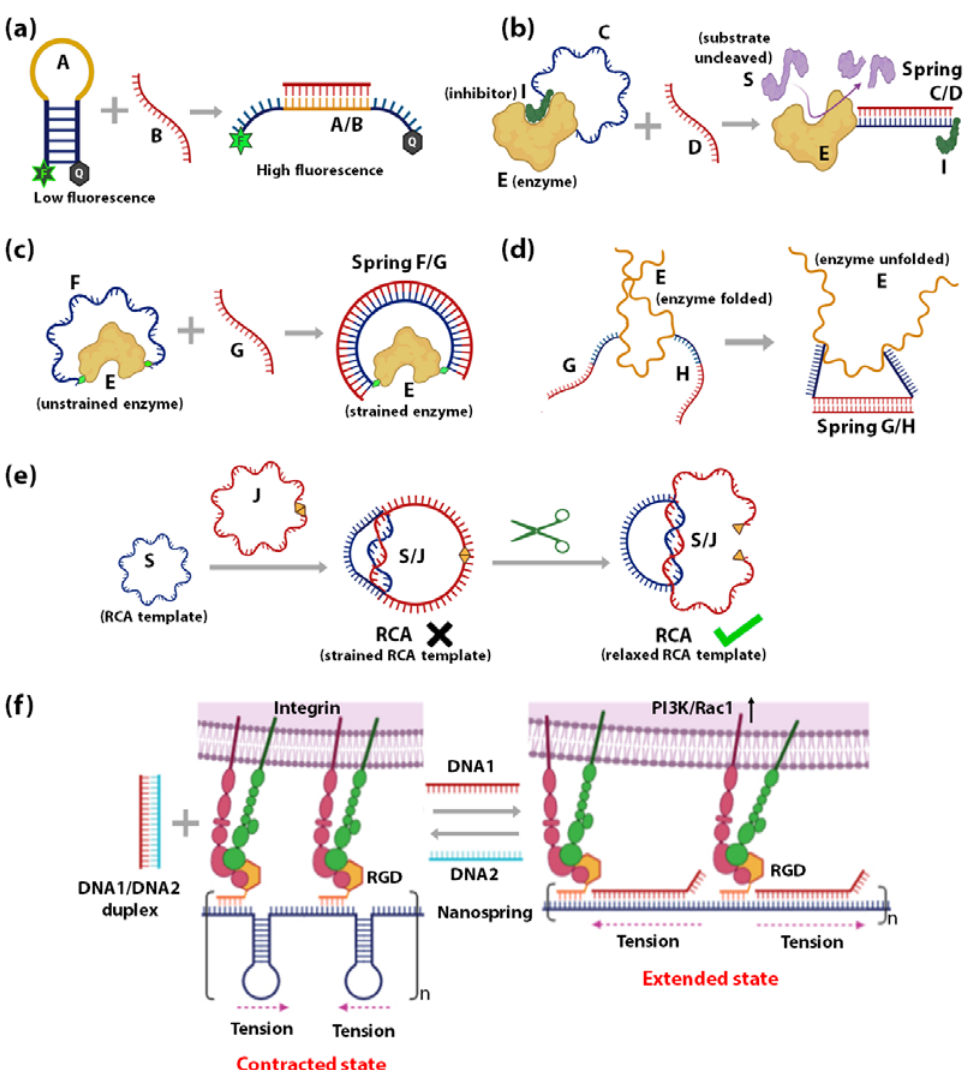
Figure 2. ( a ) Schematic representation of a DNA spring where the increased stiffness of A/B duplex does not allow the two ends of strand A to self-hybridize [116]. Schematic representation of a DNA spring regulating the catalytic activity of enzyme E ( b ) by altering the spatial proximity of the enzyme-inhibitor I with the help of the stiffness of C/D duplex [117] ( c ) by exerting mechanical force (generated due to the stiffness of F/G duplex) on the enzyme itself [115] ( d ) by pulling apart the ribozyme E tertiary structure causing it to misfold by the formation of G/H duplex [118]. ( e ) Schematic representation of a topological constraint J regulating the activity of an RCA DNA polymerase by exerting strain on the RCA template S by S/J duplex formation [119]. ( f ) Schematic representation of a DNA nanospring regulating mechanical tension by contracting membrane-bound integrins [120] . (i) Influencing the accessibility of regulatory molecules: The first strategy using DNA springs to regulate enzymes is by controlling the accessibility of enzyme regulatory factors, e.g., inhibitors. Ghadiri et al., reported the allosteric regulation of a protein enzyme Cereus Neutral Protease 5 (CNP) by a DNA